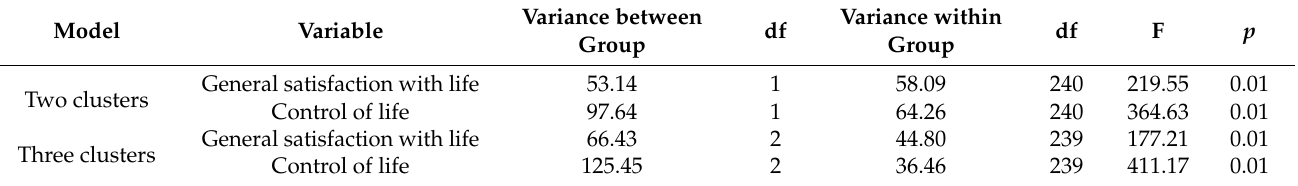
Table 1. Variance within and between groups for the Oxford Happiness Questionnaire : results of k-means cluster analysis.